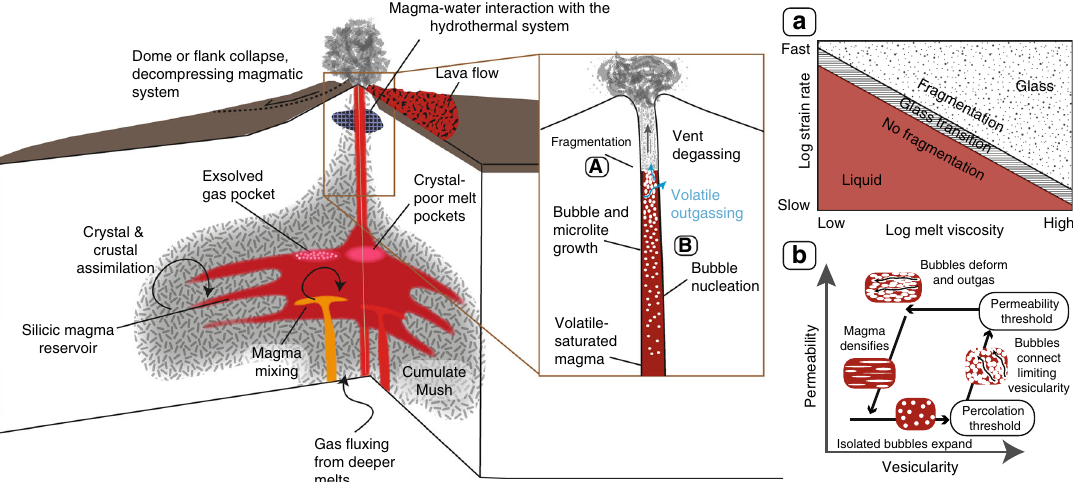
Fig. 1 Annotated volcano schematic, illustrating the range of processes that can affect eruptive style from storage to surface, prior to or during volcanic eruptions. a Shows how fragmentation is a function of the melt viscosity and strain rate. Fast strain rates (i.e., high decompression rates) favour brittle fragmentation as it passes the glass transition for a given viscosity. At slow strain rates, magma generally behaves as a liquid. Figure adapted from Gonnermann and Manga 105 . b Shows the cycle of volatile outgassing, from nucleation, coalescence to densi fi cation from permeability and porosity data in Rust and Cashman 80 , fi gure reproduced from Cashman and Sparks 5 , under fair usage